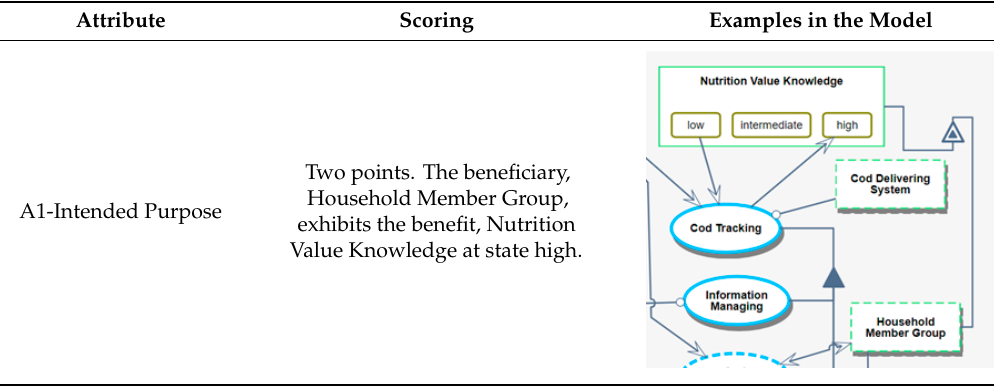
Figure A1. OPL for SD1 of codfish supply chain drawn by the expert. Table A1. Rubric assessing SD1 model of codfish supply chain.